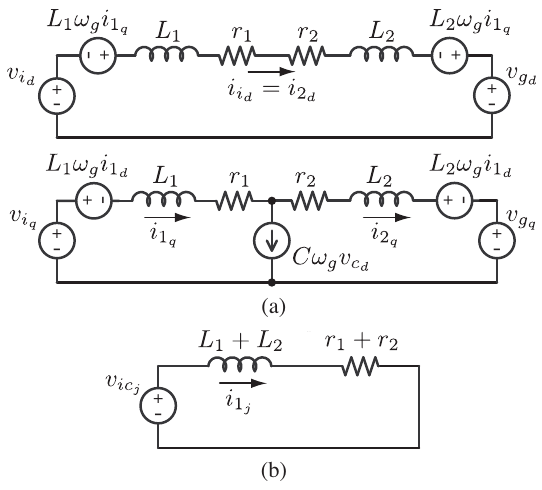
Figure 4. Low frequency dq model of the LCL filter: ( a ) with cross-coupling terms; and ( b ) simplified by using feed-forward control technique ( j = { d , q } ).